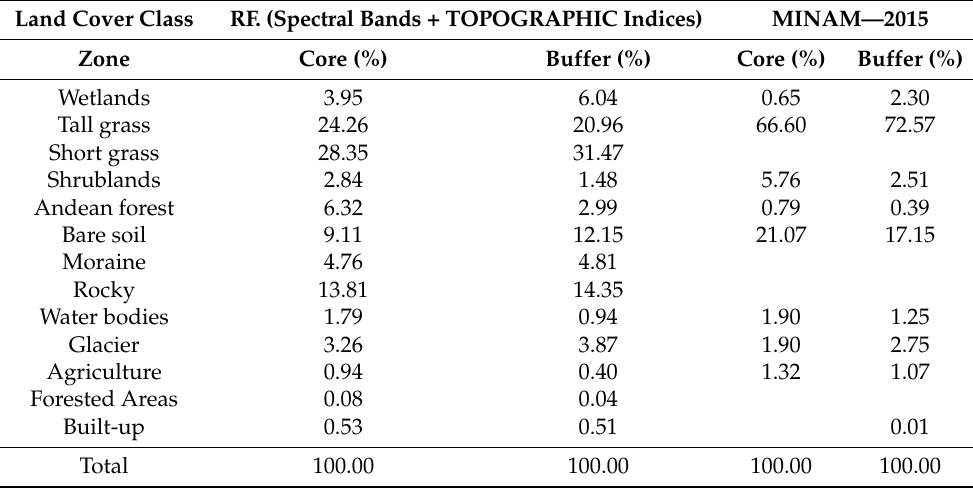
Table 6. Distribution of the surface area of each land cover class for the core and buffer zone of RPNYC in